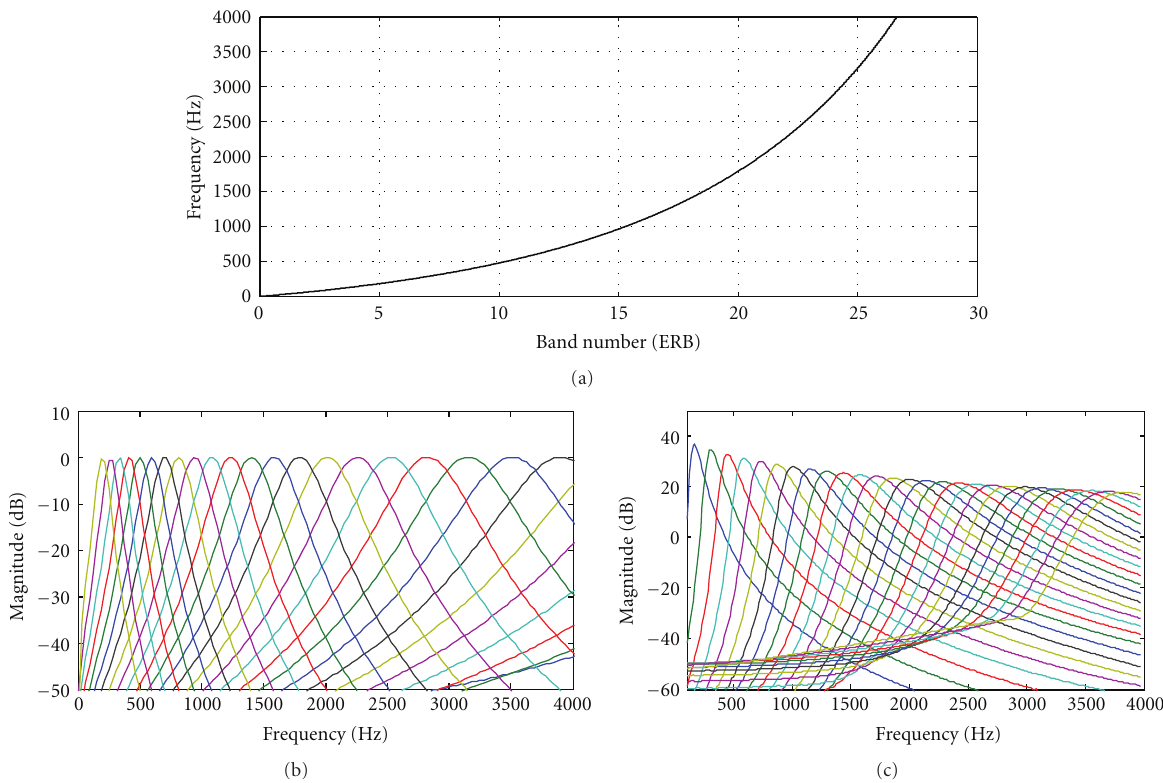
Figure 2: Frequency and ERB-scale correspondence (a) and the frequency response of the gammatone filter banks (b) and the gammachirp filter banks (c) with k = 27 ERB bands.